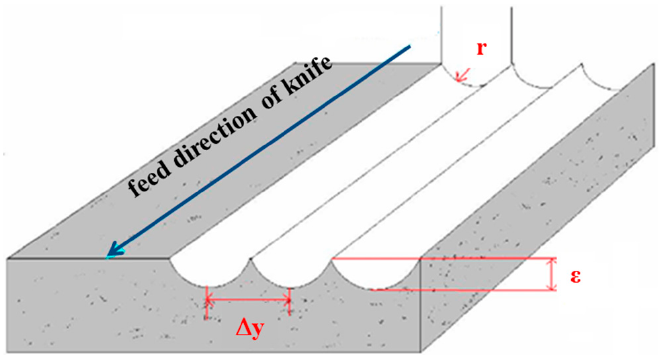
Figure 6. Scallop will happen between machined path intervals.